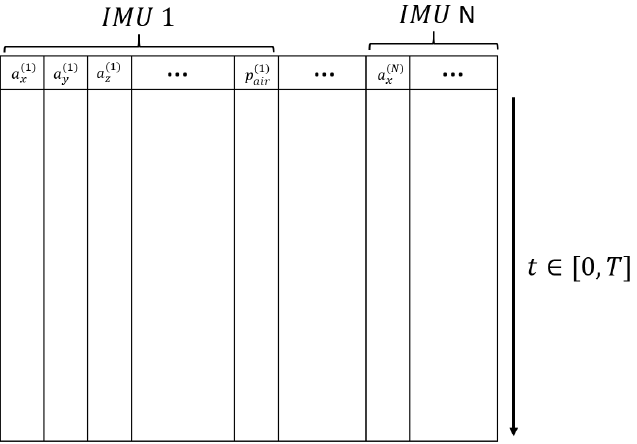
Figure 3. The figure shows how the channels are arranged in one window. All channels of an inertial measurement unit (IMU) are stringed together and are then merged with the channels of the other